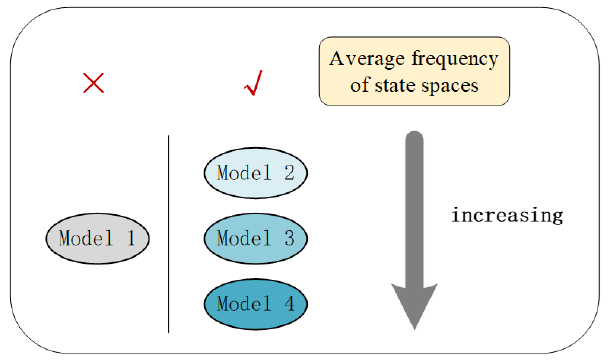
Figure 9. Comparison of the average of state spaces frequencies.